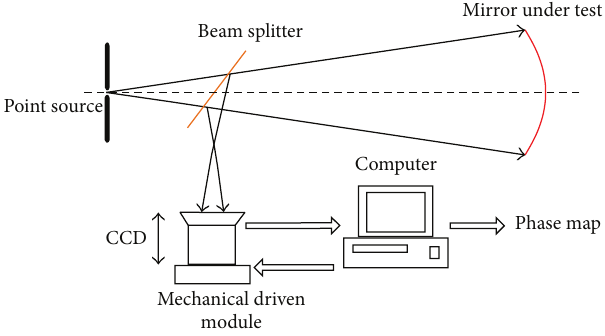
Figure 1: Framework of traditional PROSM